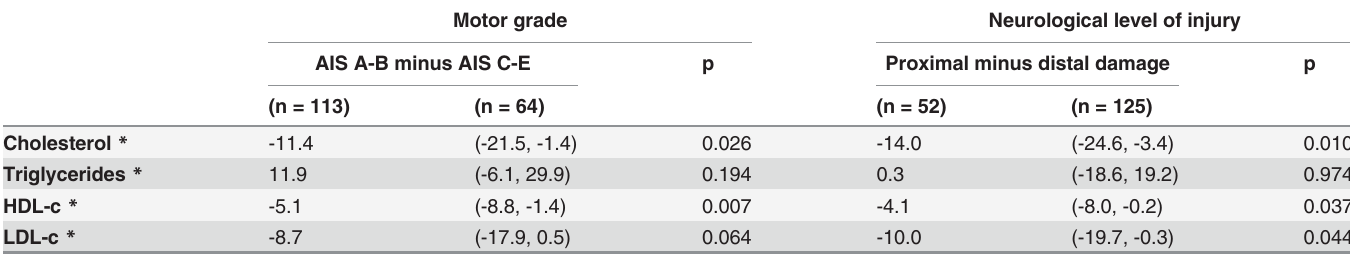
Table 2. Differences in serum lipids classi fi ed according to motor grade and neurological level of